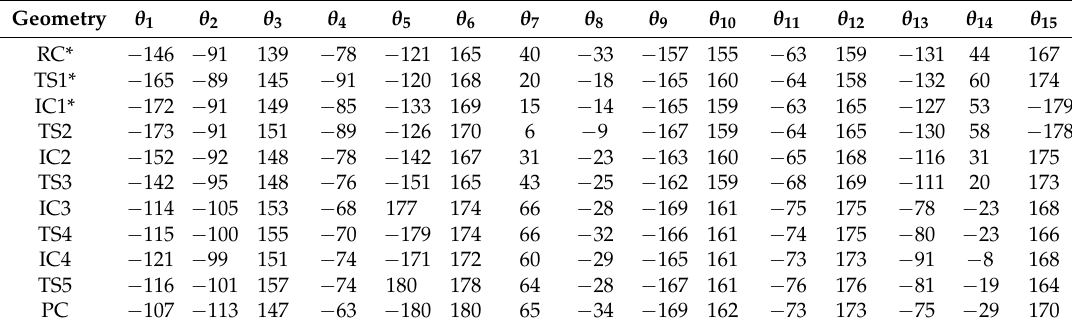
Table 2. The heavy-atom dihedral angles θ 1 – θ 15 ( ◦ ) defined for the 15-membered ring as in Figure 1. The geometries labeled by an asterisk (*) are those previously reported